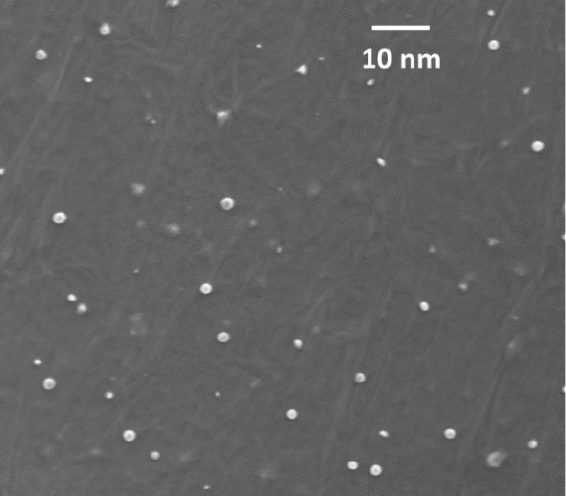
Figure 2. Typical SEM image of N-CQDs nanoparticles.